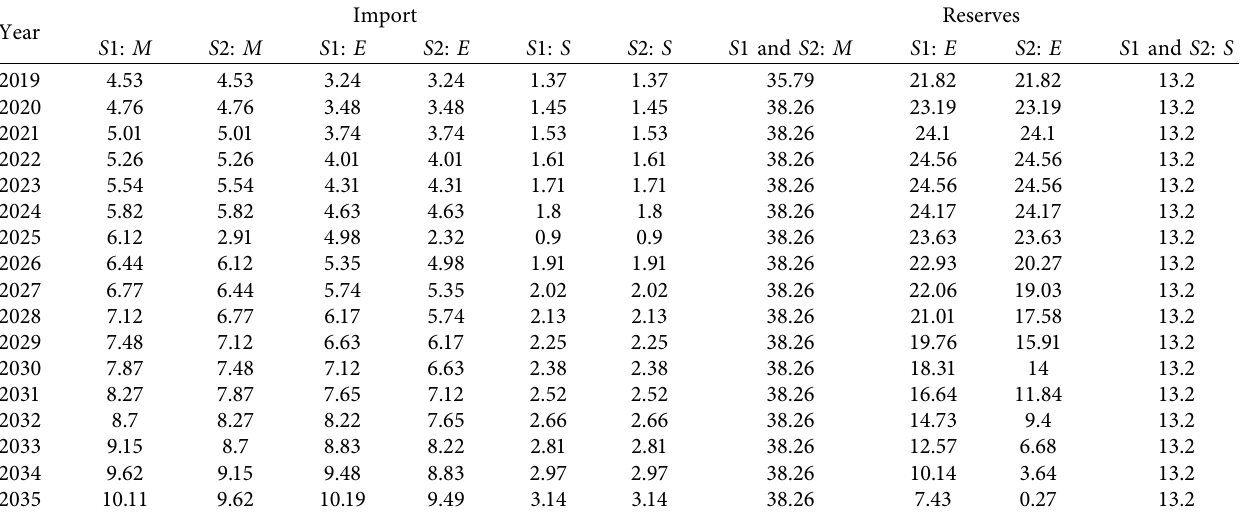
Table 3: Model results of mineral resources industrial reserve system (trillion